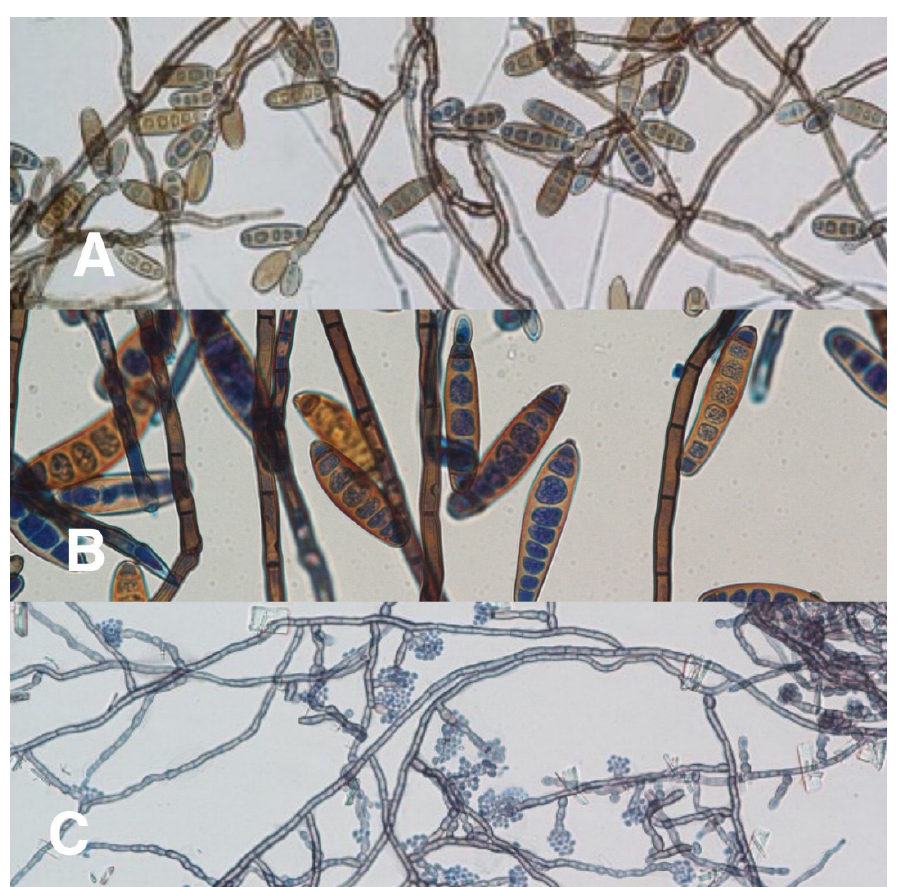
Figure 6. Microbiological identification of dematiaceous keratitis from corneal scraping specimens at 400 magnification. ( A ) Microscopic examination of Bipolaris spp. obtained from a slide culture; ( B ) microscopic examination of Exerohilum spp. obtained from a slide culture; ( C ) microscopic examination of Phialophora spp. obtained from slide culture.